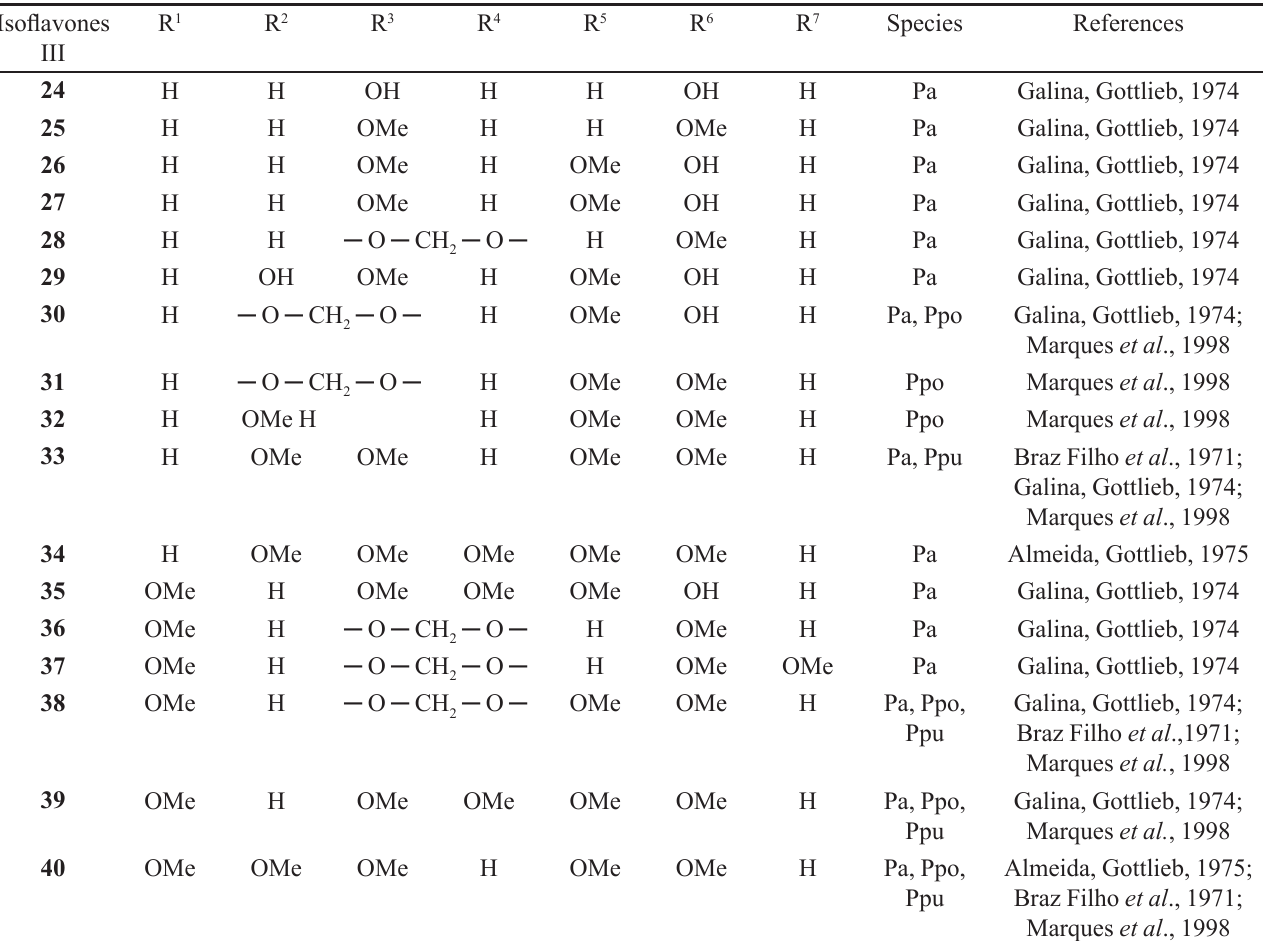
TABLE V - Structure of the isoflavones based on molecule III , identified from the Pterodon genus